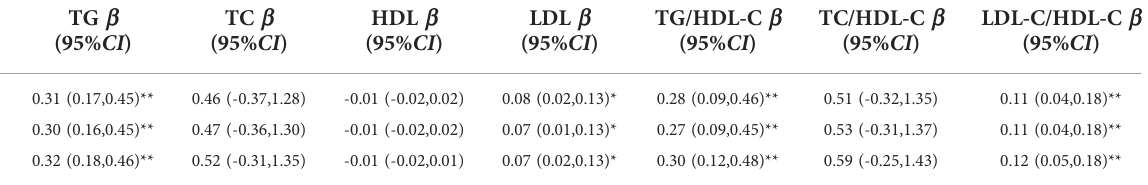
TABLE 3 Multiple mixed-effect linear regression